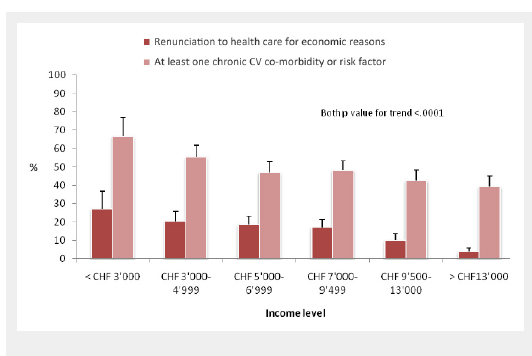
Health care renunciation for economic reasons during the previous 12 months and cardiovascular co-morbidity or risk factor among a representative sample of 35 to 74 year old citizens of the canton of Geneva, Switzerland